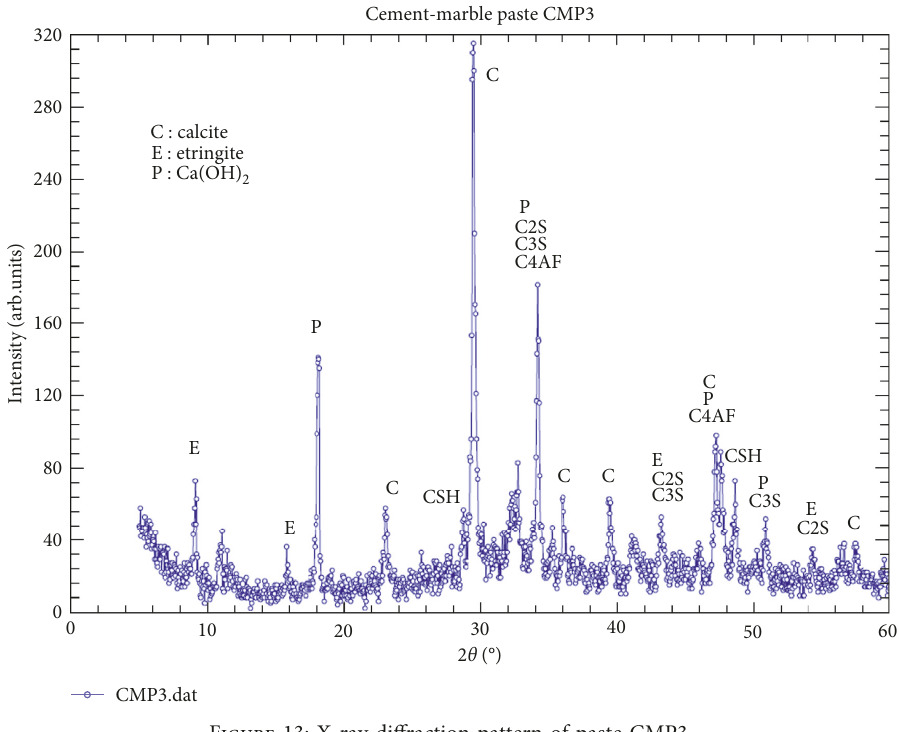
Figure 13: X-ray diffraction pattern of paste CMP3.